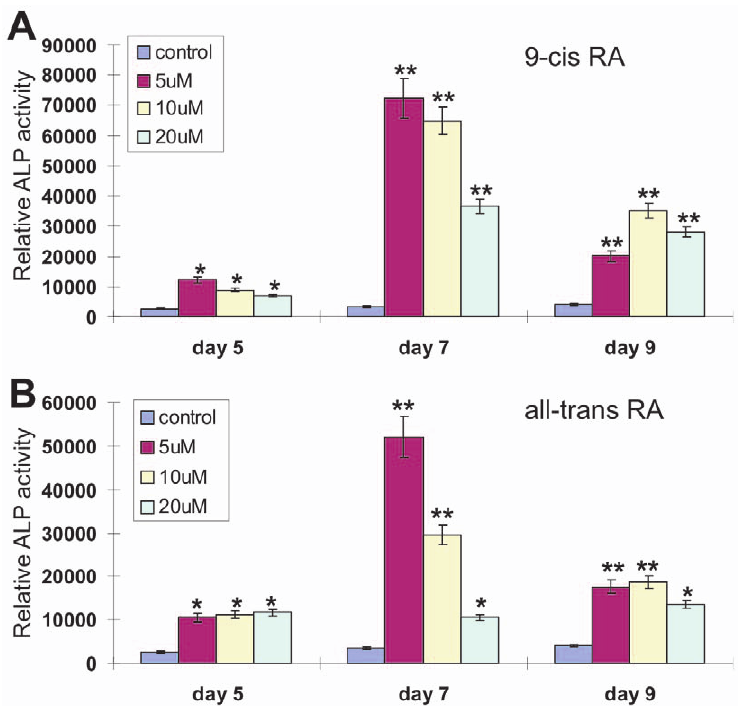
Figure 1. Retinoic acids induce osteogenic differentiation of mesenchymal progenitor cells (MPCs). ( A ) 9-Cis-retinoic acid (9CRA) induces ALP activity in MPCs. Subconfluent C3H10T1/2 cells were treated with varying concentrations of 9CRA or solvent control. ALP activity was measured at the indicated time points. Each assay condition was carried out in triplicate in at least two independent batches of experiments. ‘‘*’’, p , 0.05 ; ‘‘**’’, p , 0.001 (vs. control groups). ( B ) All-trans-retinoic acid (ATRA) induces ALP activity in MPCs. C3H10T1/2 cells were treated with varying concentrations of ATRA or solvent control. ALP activity was measured at the indicated time points. Each assay condition was carried out in triplicate in at least two independent batches of experiments. ‘‘*’’, p , 0.01 ; ‘‘**’’, p , 0.001 (vs. control groups).